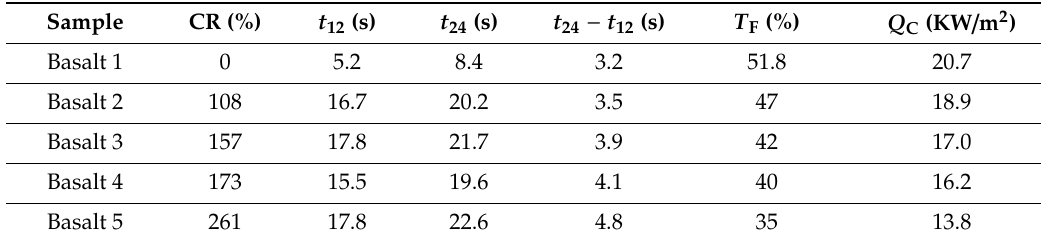
Table 2. Heat transfer parameters of un-sized basalt fabrics coated with di ff erent silicone content (CR